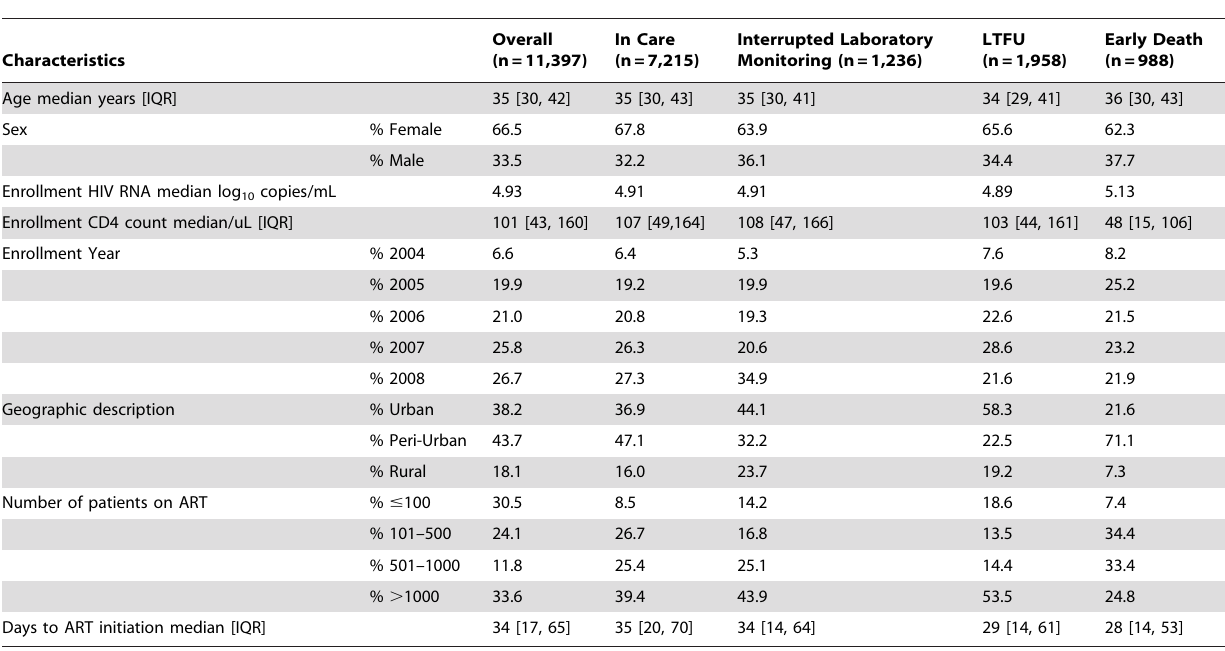
Table 1. Summary of baseline patient and clinic characteristics in a cohort study of LTFU in a large South African ART program.